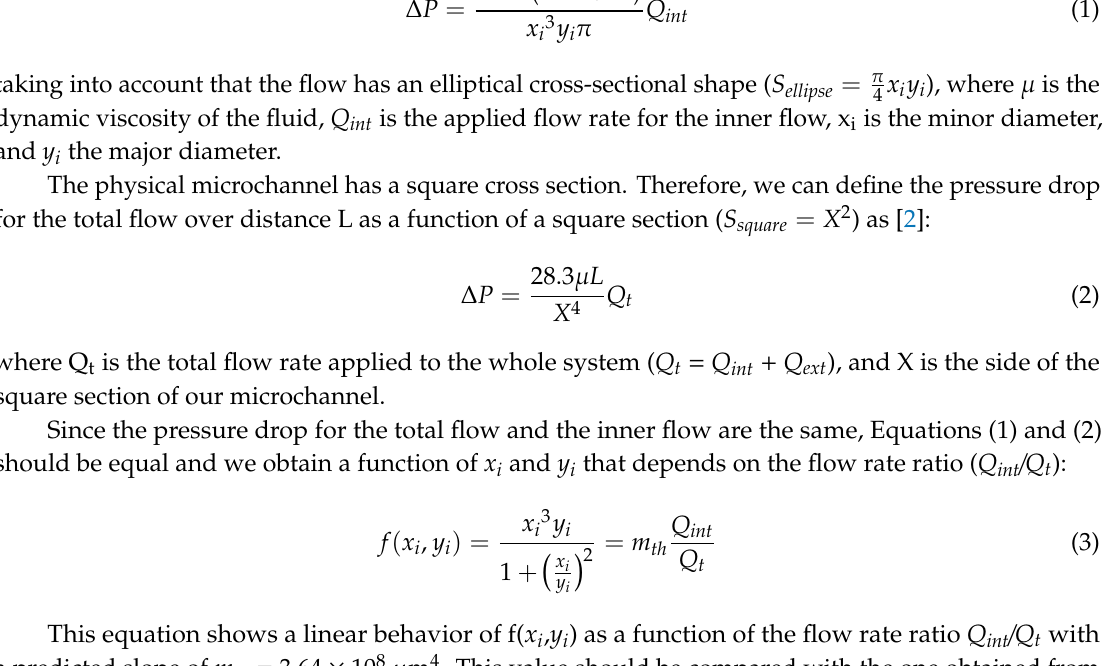
Figure 3. Representation of the Poiseuille velocity profile of our microfluidic system in the ( x , z )-plane. The inner flow is represented in blue and the outer flow in white. A single parabolic profile is the result of the miscibility of the fluids. As consequence, the pressure drop from point P2 to P1 of the total flow (inner and outer flow) and the pressure drop in the inner flow from P2 to P1 are the same.